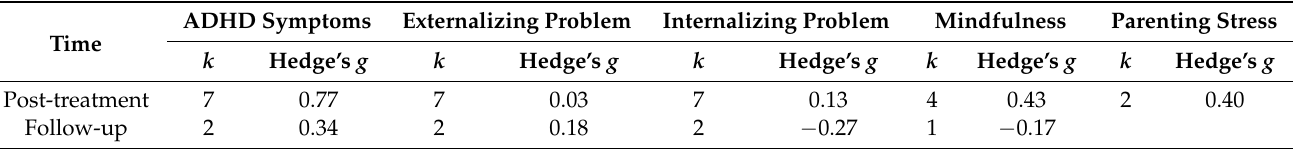
Figure 3. Funnel plot for ADHD symptoms. Table 3. Average effect sizes by types of outcome by times of measurement.